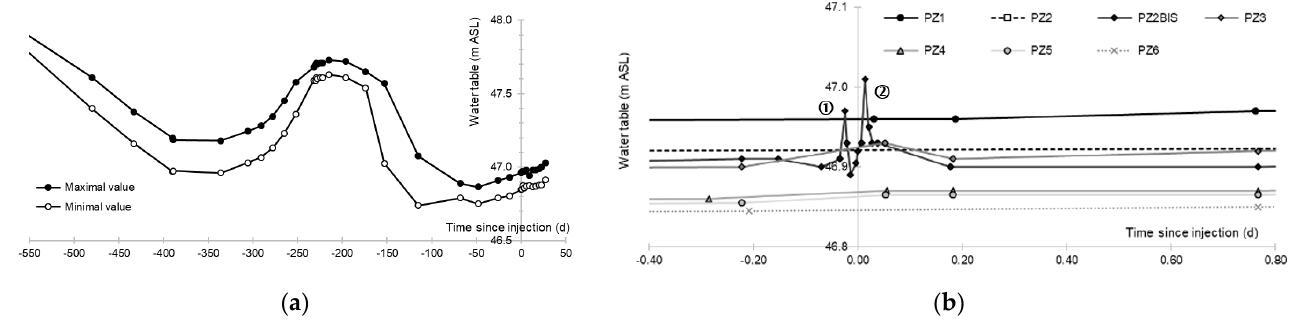
Figure 8. Piezometric monitoring of the experimental site: ( a ) piezometry from the start of monitoring; and ( b ) piezometry before and after the injections.